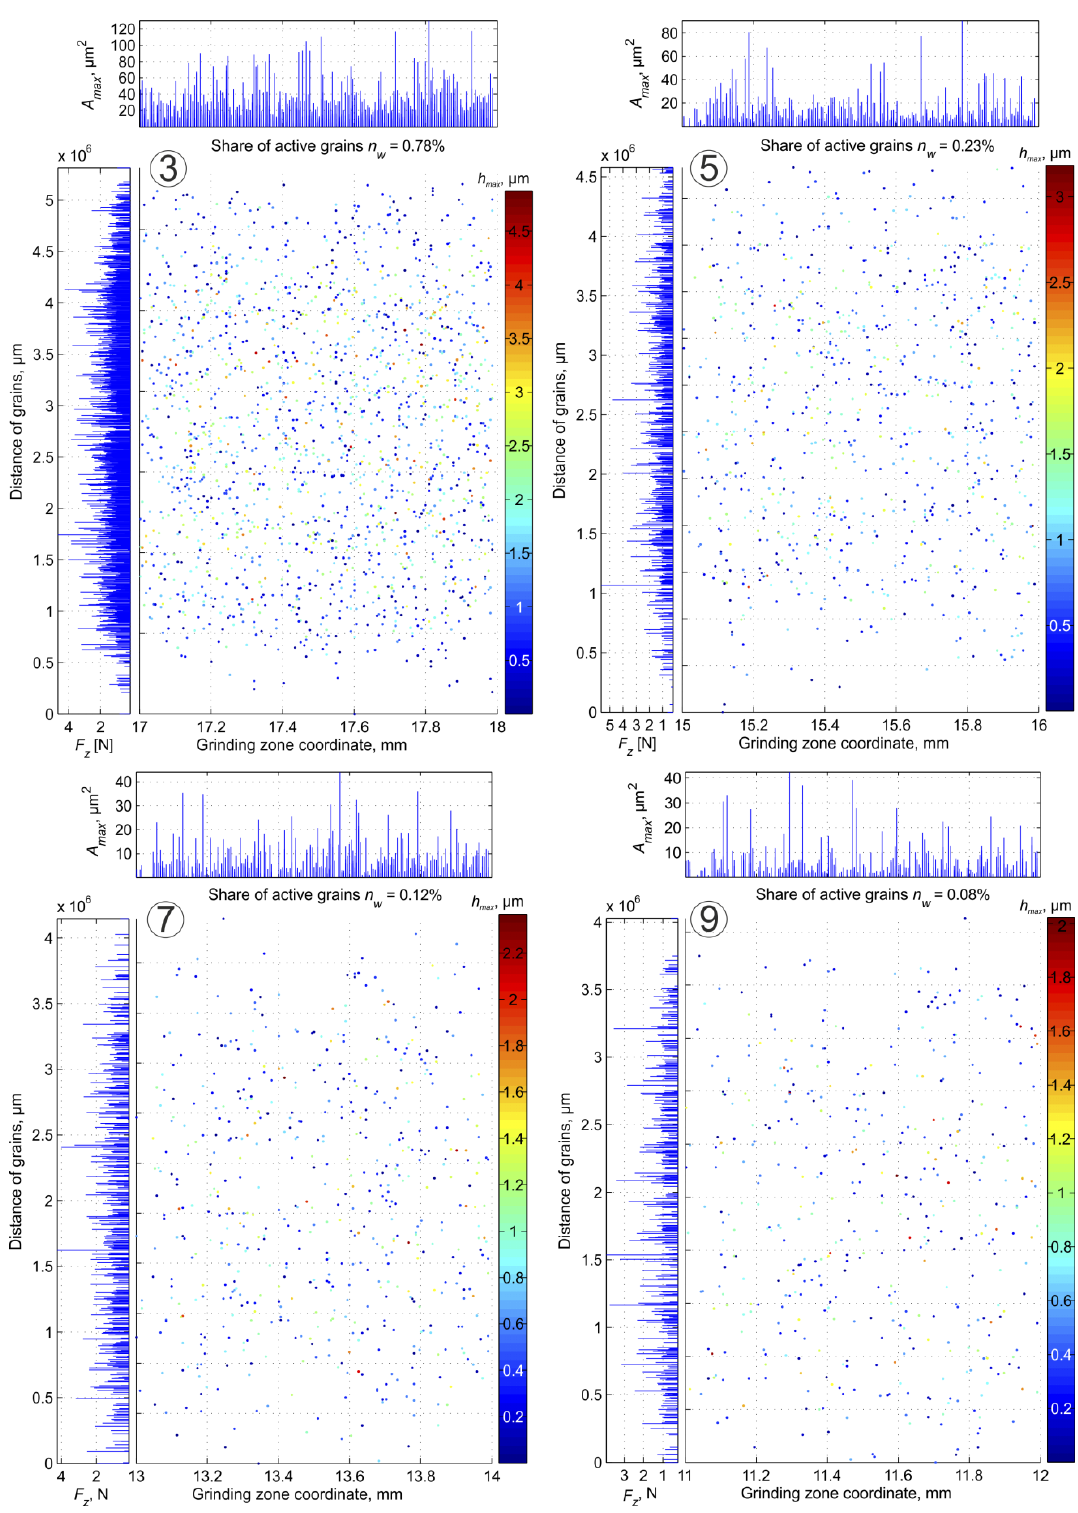
Figure 5. Maps of grain activity in Zones 3, 5, 7, 9 (according to Figure 4)—the width of the zone is equal to the value of the traverse feed rate.